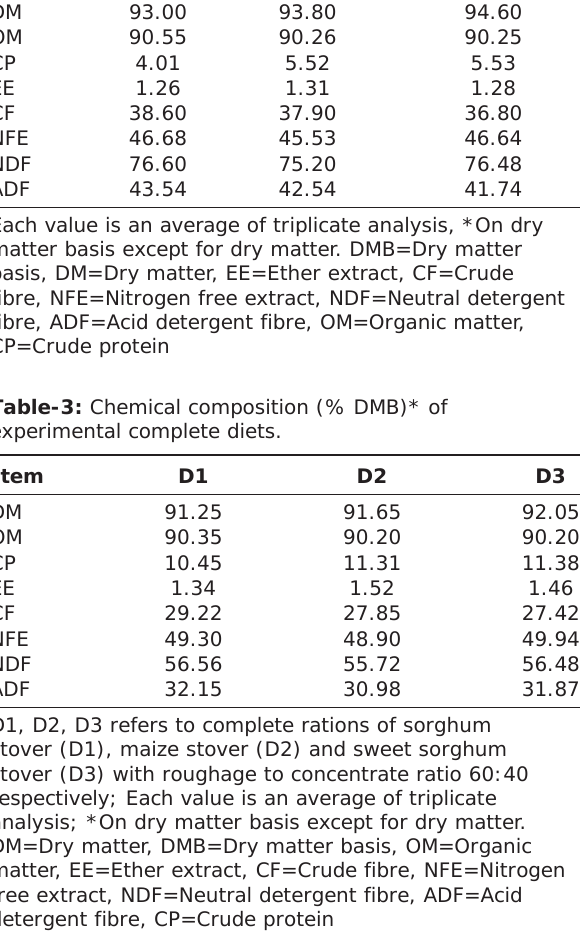
Table-2: Chemical composition (% DMB)* of experimental stovers. Item Sorghum stover